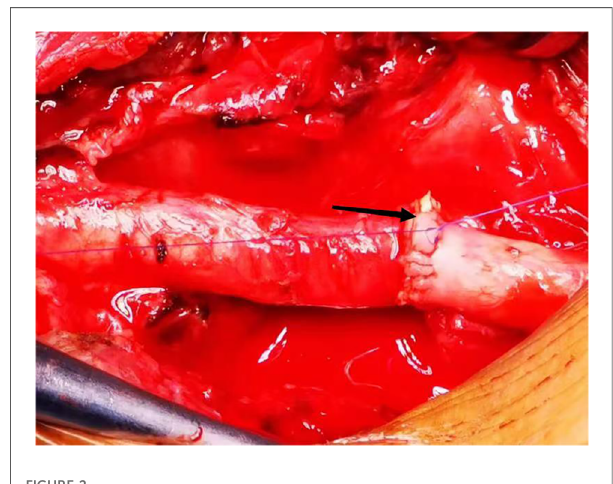
FIGURE 2 Intraoperative view. The fi stula opening in the upper esophagus